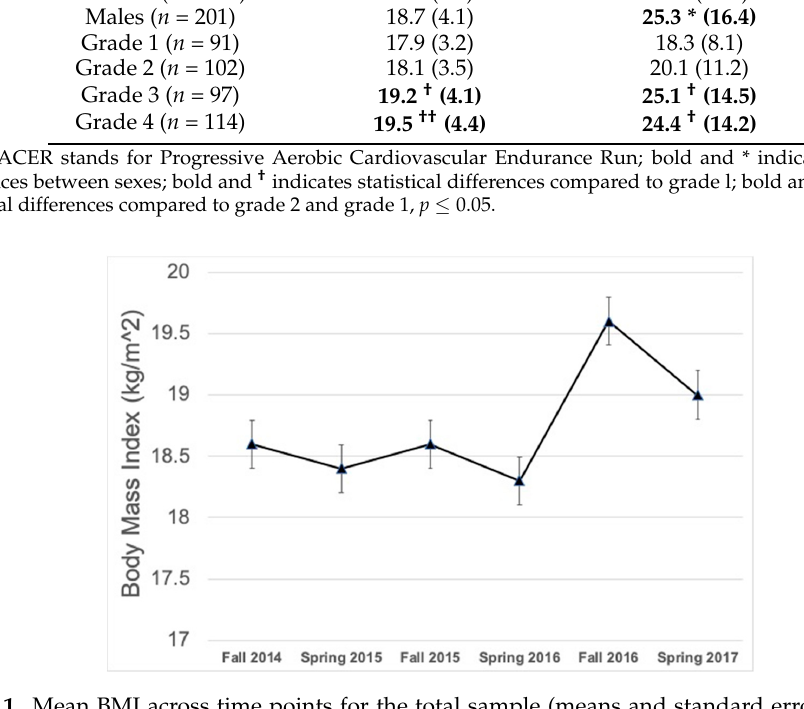
Figure 1. Mean BMI across time points for the total sample (means and standard errors; n = 404). Note : BMI stands for body mass index.